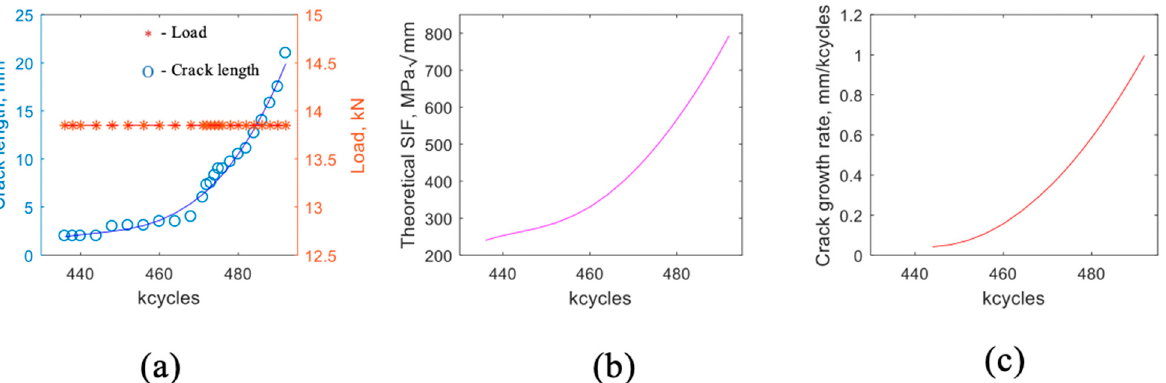
Figure 8. Load-controlled fatigue-experiment results: ( a ) fatigue kcycles vs. crack length and load; ( b ) fatigue kcycles vs. SIF; ( c ) fatigue kcycles vs. crack growth rate.